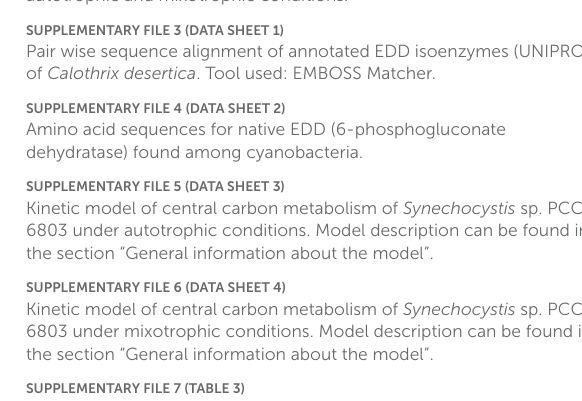
SUPPLEMENTARYFILE2(TABLE2) List of kinetic parameters employed in the simulations. Data for autotrophic and mixotrophic conditions. SUPPLEMENTARYFILE3(DATASHEET1) Pair wise sequence alignment of annotated EDD isoenzymes (UNIPROT) of Calothrix desertica . Tool used: EMBOSS Matcher. SUPPLEMENTARYFILE4(DATASHEET2) Amino acid sequences for native EDD (6-phosphogluconate dehydratase) found among